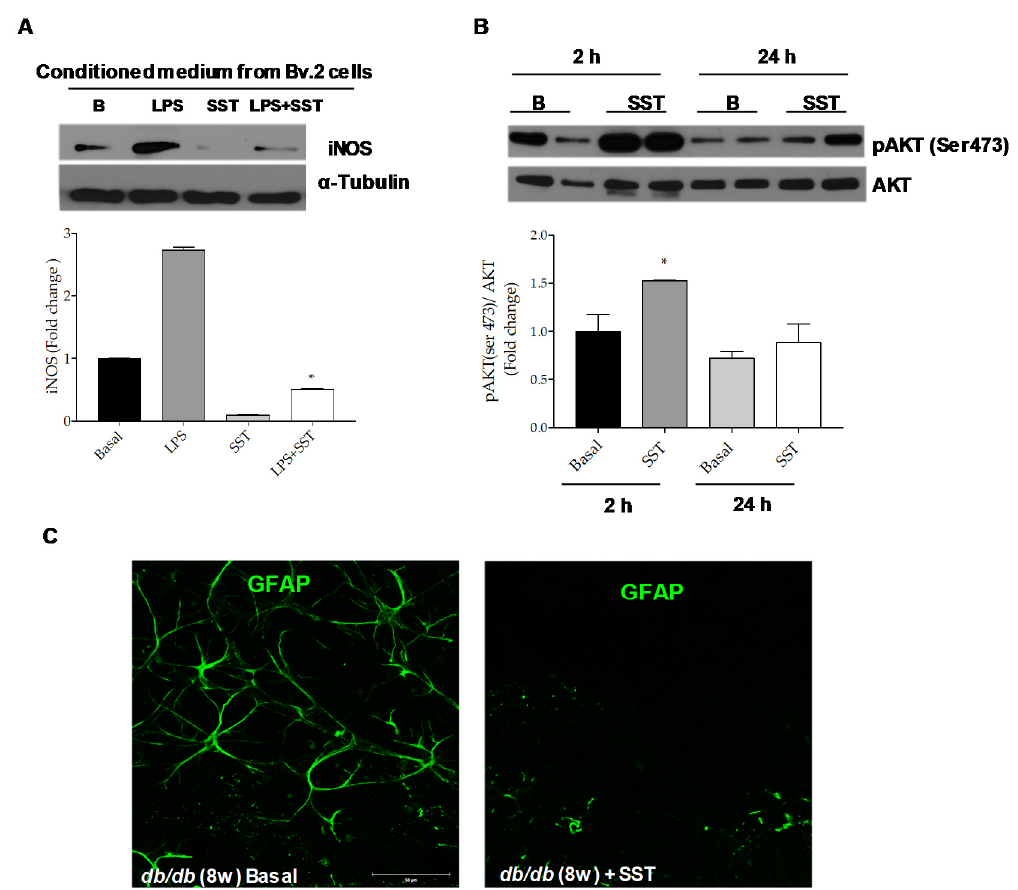
Figure 7. Beneficial effects of SST against inflammation in retinal explants. ( A ) Retinal explants from 8-week-old C57BL/6J mice were treated for 24 h with conditioned medium (CM) from LPS-stimulated Bv.2 cells in the absence or presence of SST (10 -5 M) pre-treatment (4 h). Western blot was conducted with antibodies against iNOS and α -Tubulin as loading control. Representative autoradiograms are shown (n = 4 retinas per condition). ( B ) Retinal explants from 8-week-old C57BL/6J mice were treated for 2 or 24 h with SST (10 -5 M) and analyzed by Western blot with antibodies against phosphorylated AKT (Ser473) and total AKT. Representative autoradiograms are shown. Blots were quantified by scanning densitometry and the results are mean ± SEM (n = 4 independent experiments). The fold change relative to the basal condition is shown. * p ≤ 0.05 vs. basal (two-way ANOVA followed by Bonferroni t -test). ( C ) Retinal explants from db/db mice at 8 weeks of age were treated with SST (10 -5 M) (right panel) or vehicle (DMSO) (left panel) for 24 h. Immunostaining for GFAP (green) was carried out in whole retinas. Representative images are shown (n = 4 retinas per condition).